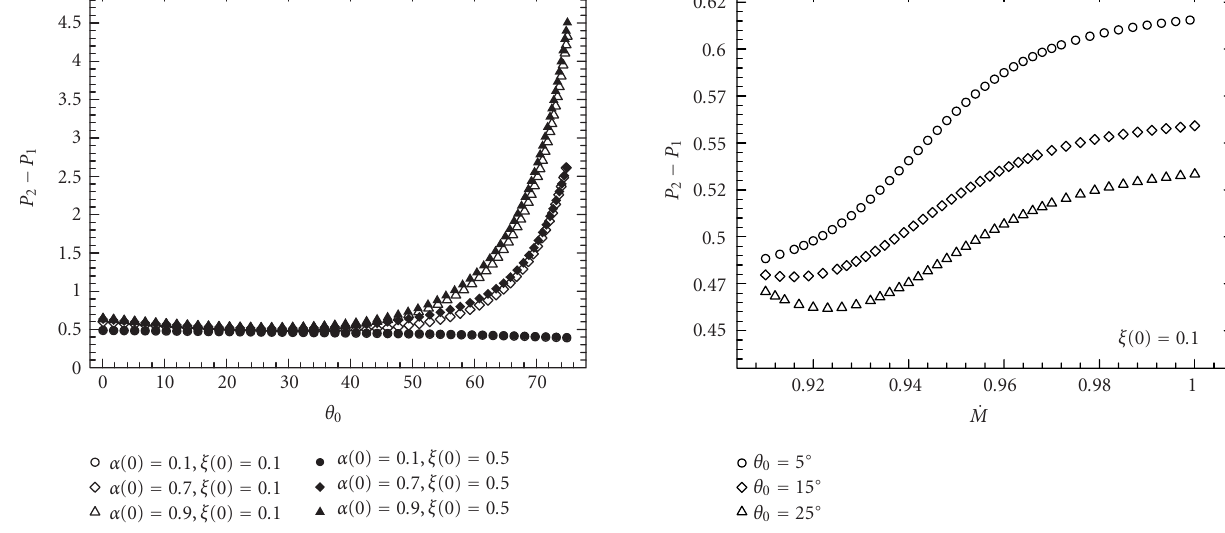
Figure 19: The simulated compressor characteristics at smaller inlet size of distorted region of 0 .